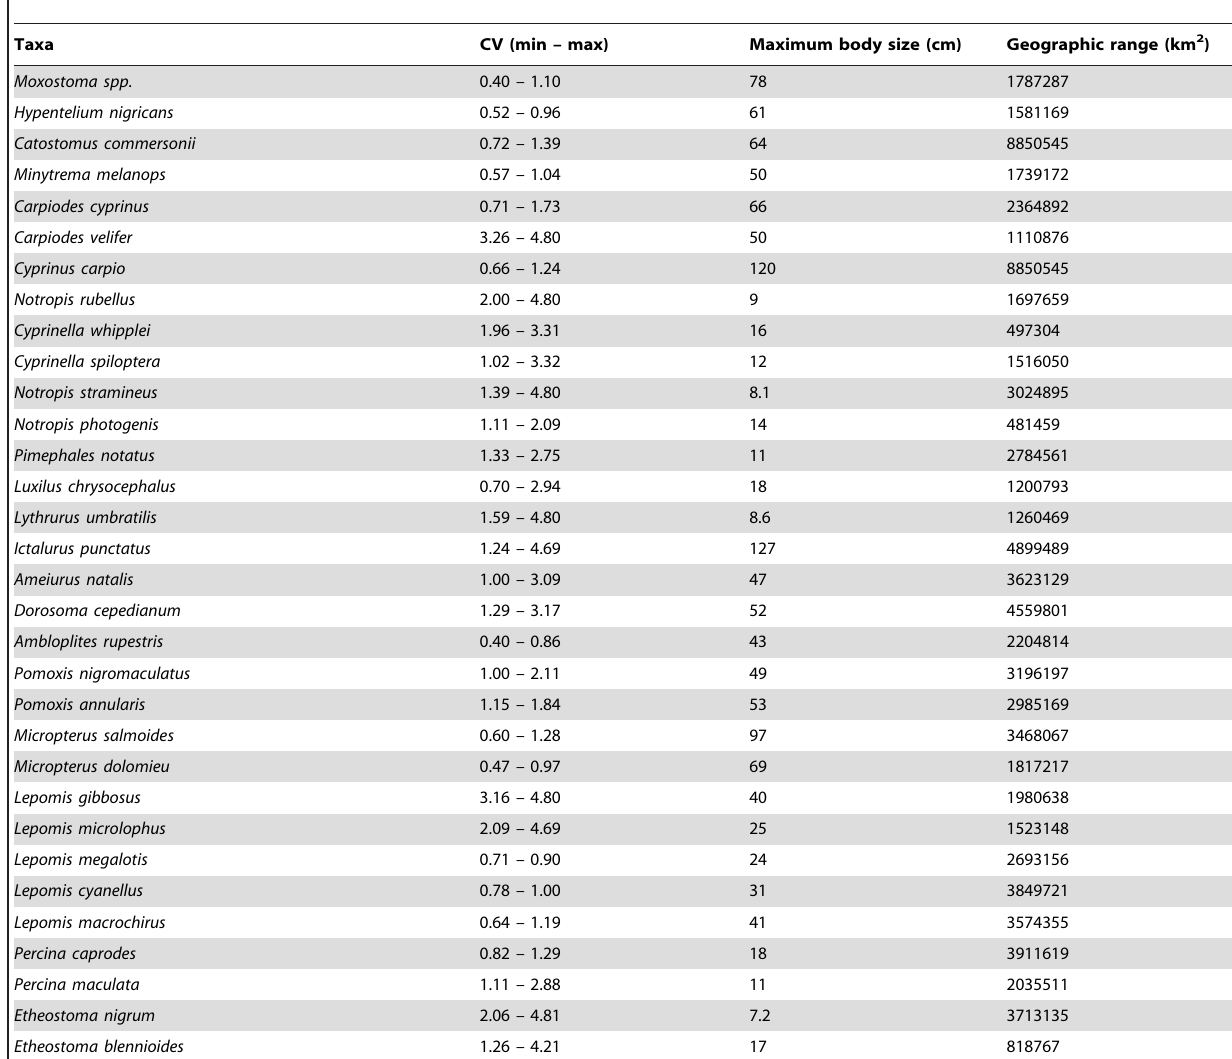
Table 1. Species included in analysis with descriptions of CV (long term population variation among sites), maximum body size (cm), and geographic range (km 2